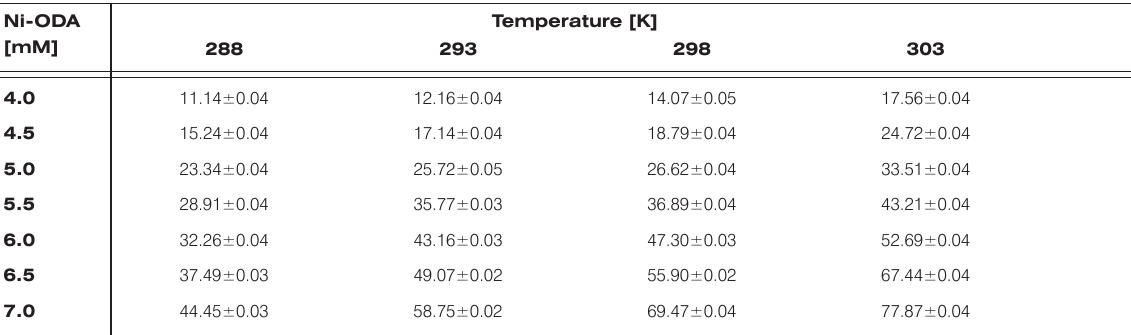
Table 2. Concentration and temperature dependences of rate constants k (s -1 ) (± standard derivation) of the substitution of Ni-ODA with phen. The concentration of phen is constant and equals to 2.88 mM. Ni-ODA